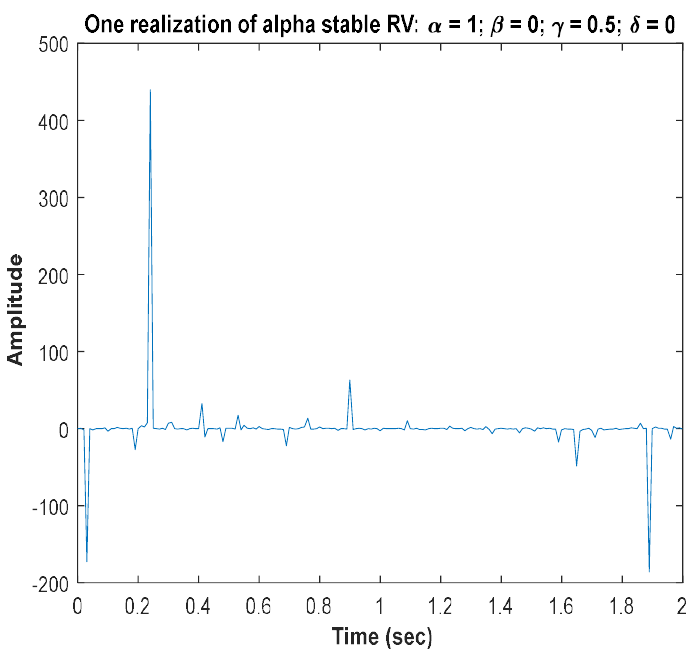
Figure 12. α-Stable noise in time domain. It is impulsive.